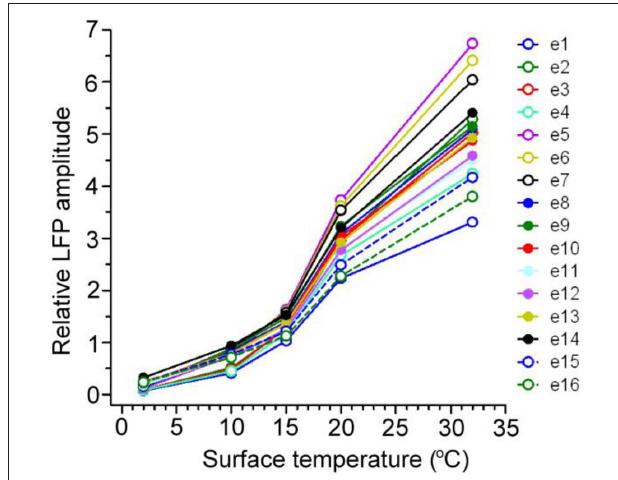
Figure 3 | The rMS amplitudes of 16 simultaneously recorded auditory-evoked potentials (e1–e16) at a series of cooled temperatures (32, 20, 15, 10, and 2 ° C) are shown for a representative example. Evoked field potentials were reduced by cooling at a similar rate across the span of auditory cortex in all cases.